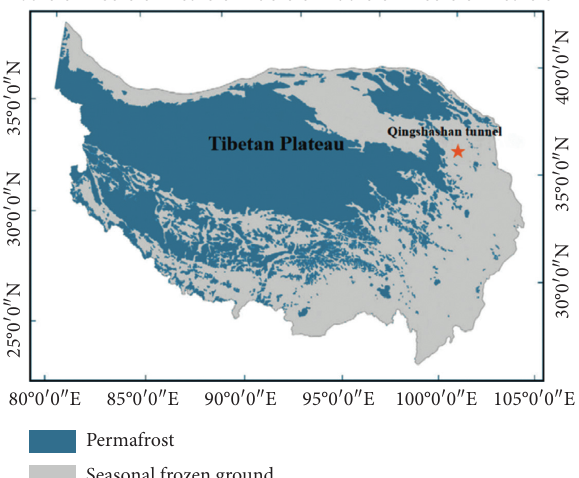
Figure 2: The location of the Qingshashan tunnel in the Tibetan Plateau and distribution of